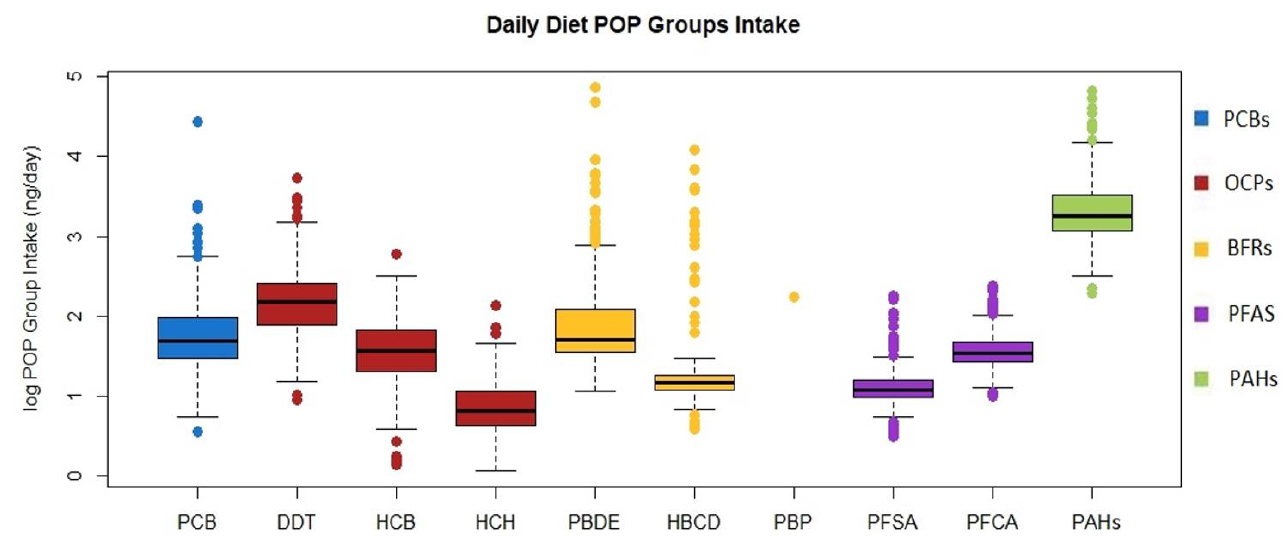
Figure 3. Daily intake of ∑PCB congeners, ∑DDT isomers , and their metabolites, HCB, ∑HCH isomers, ∑PBDE congeners , ∑HBCD isomers, PBP, ∑perfluorinated sulfonates, ∑perfluorinated carboxylic acids, and ∑PAHs .